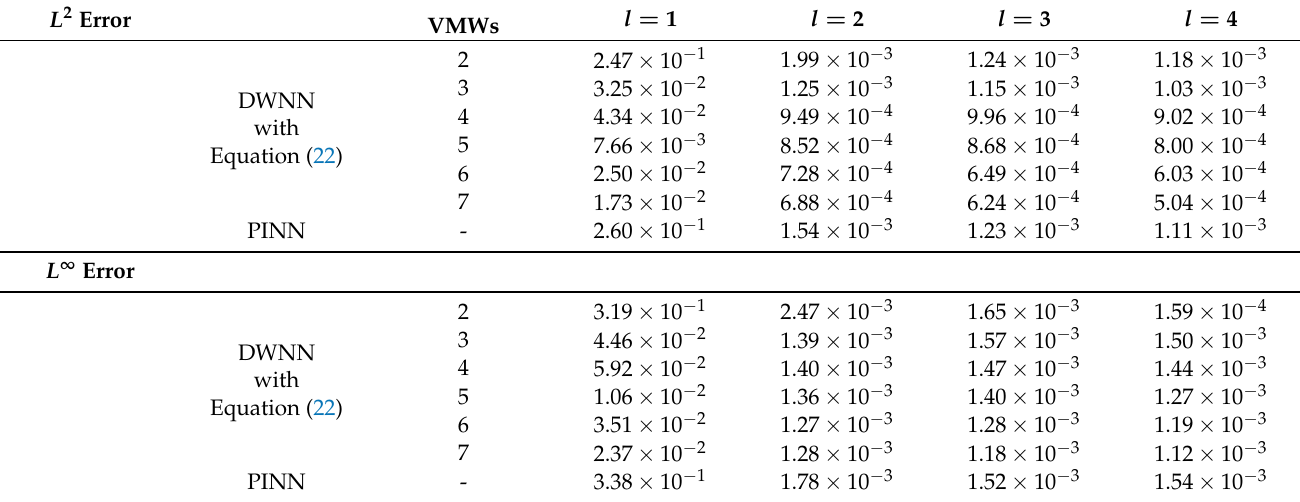
Table 1. The L 2 errors and L ∞ errors for 1D Schr¨odinger.